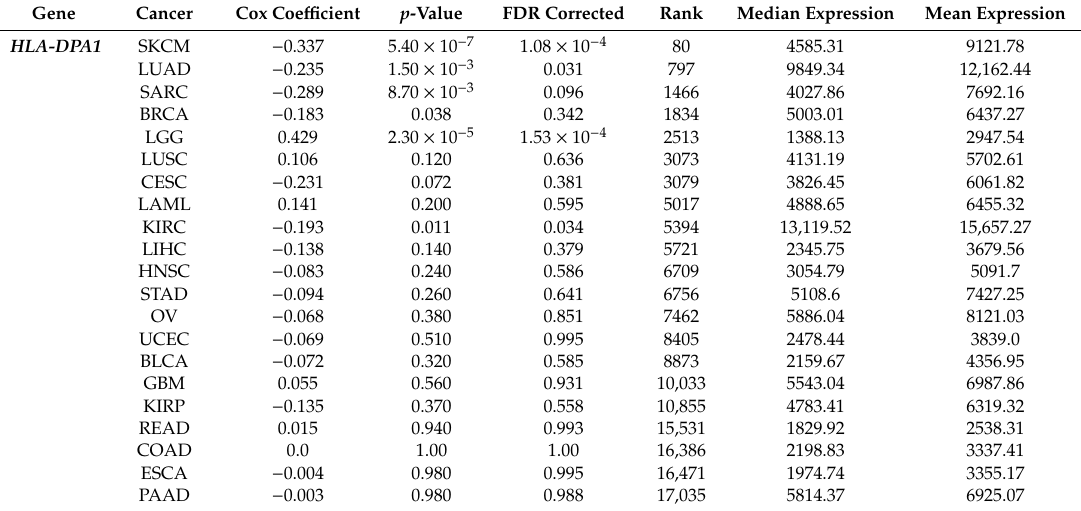
Table 3. Association of HLA-DPA1 expression in cutaneous melanoma with survival were compared across cancer